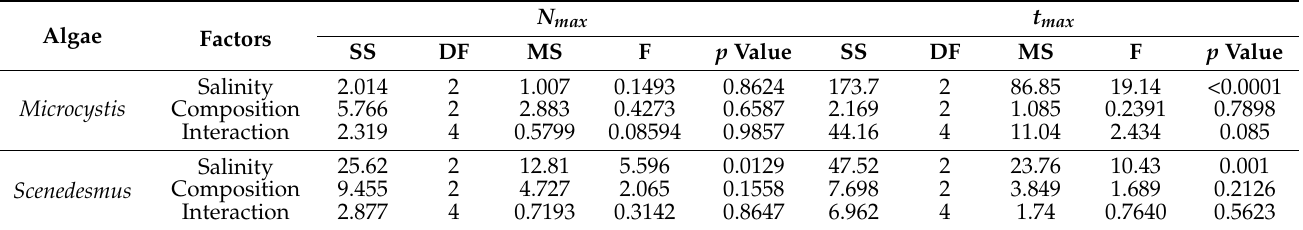
Table 2. Summary of two-way ANOVAs for the effects of salinity and initial algal composition on the maximal values of algal abundance ( N max ) and the time to N max ( t max ) of M. aeruginosa and S. obliquus